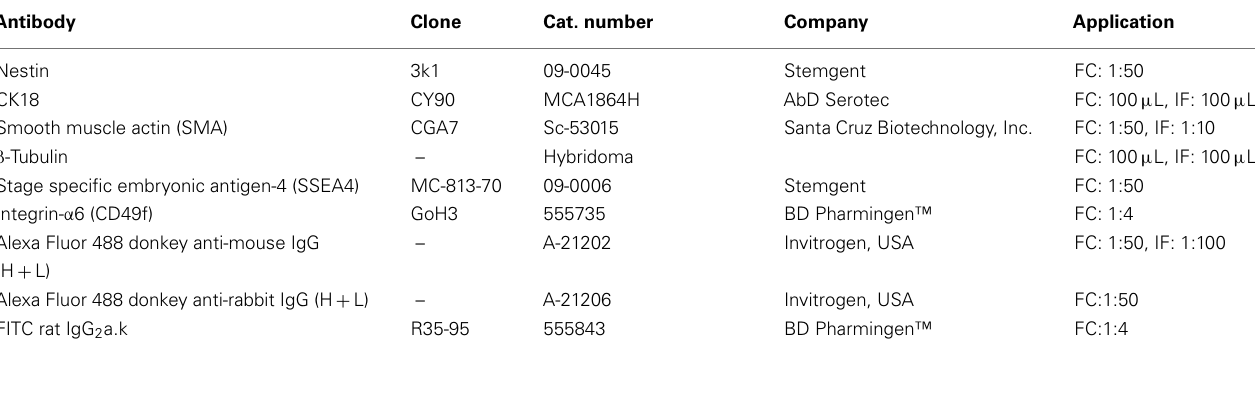
Table 2 |Antibodies